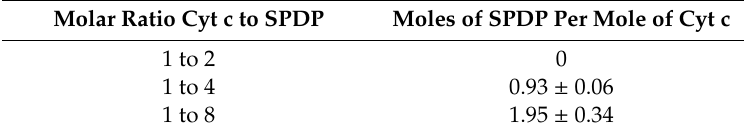
Table 1. Cytochrome c modification with SPDP at di ff erent molar ratios of Cyt-c-to-linker a . Molar Ratio Cyt c to SPDP